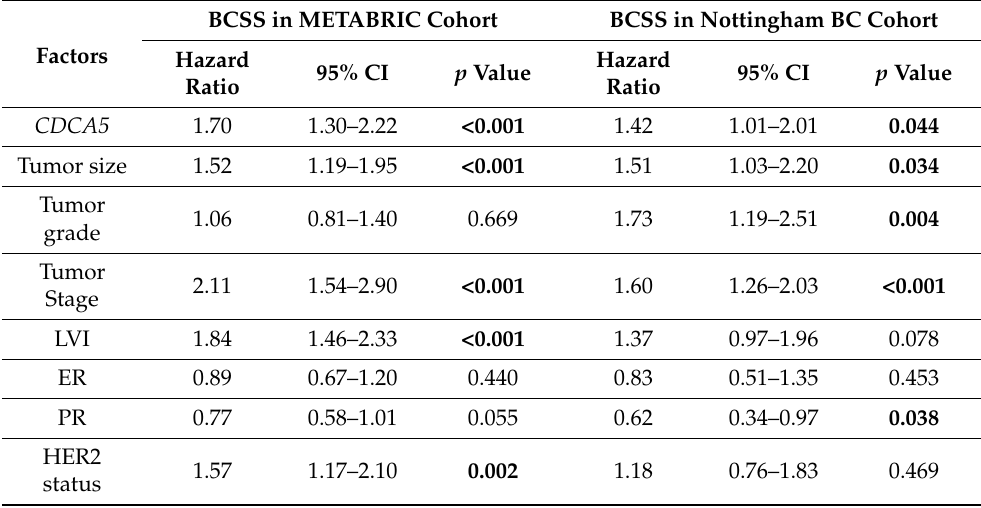
Significant correlations are in